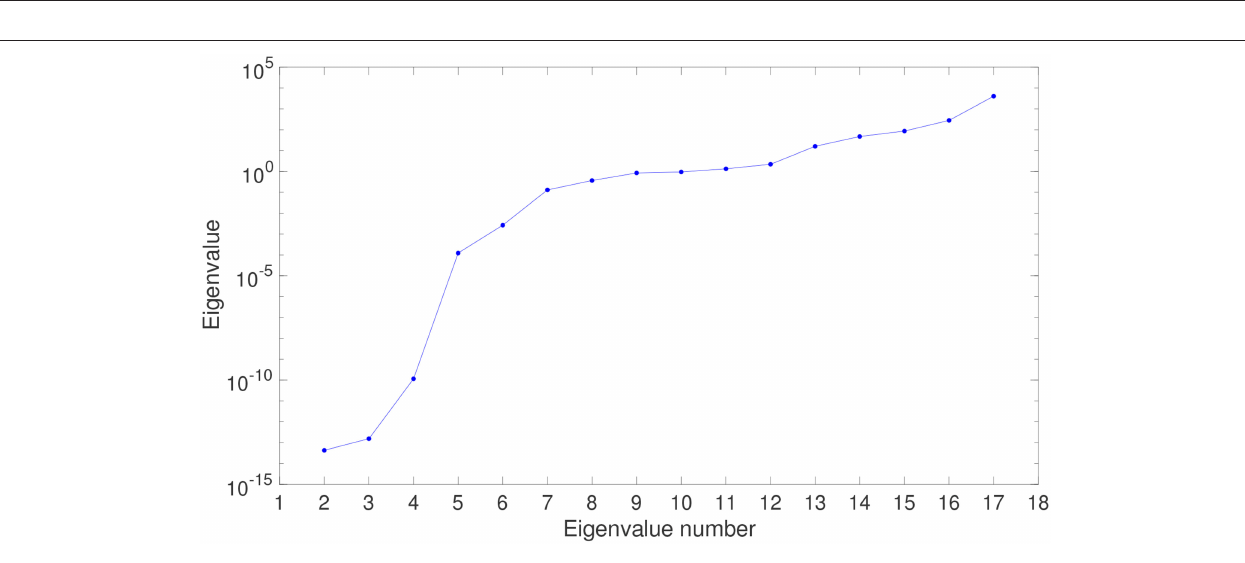
FIGURE 5 | Evolution of the eigenvalues of the projection matrix in the embedding of experimental data. Only the first 17 eigenvalues are shown for clarity.